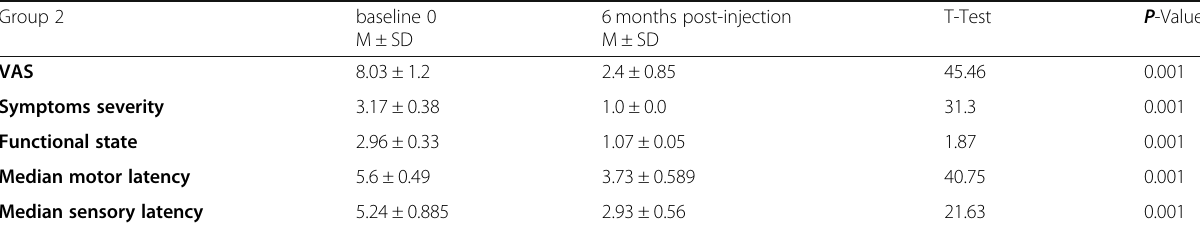
Table 3 Visual analogue scale, Boston questionnaire of CTS and electrophysiological parameters of median nerve in the second group of patients at 6 months post-surgery compared to baseline parameters